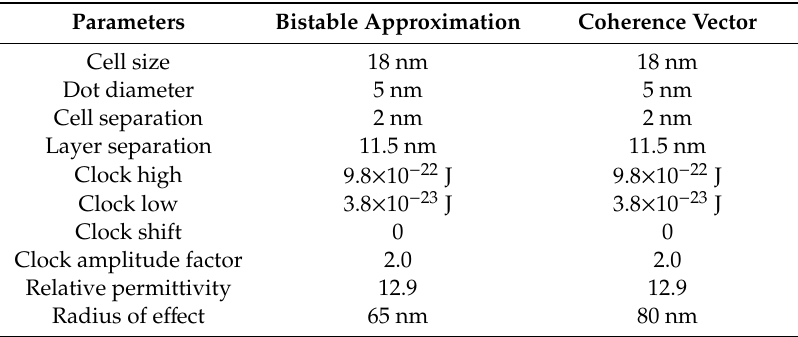
Table 3. Simulation parameters.